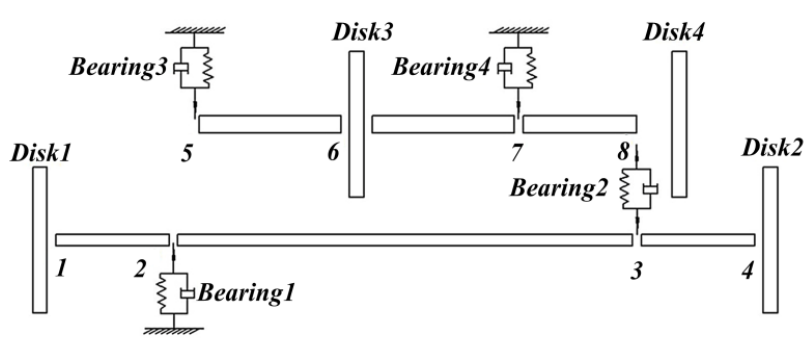
Figure 6. Yang’s finite element model of the dual-rotor system [24].